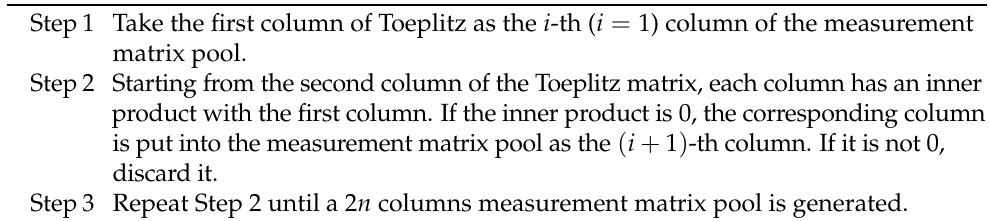
Algorithm 2 is the selection method proposed in [4], named parallel compression sensing